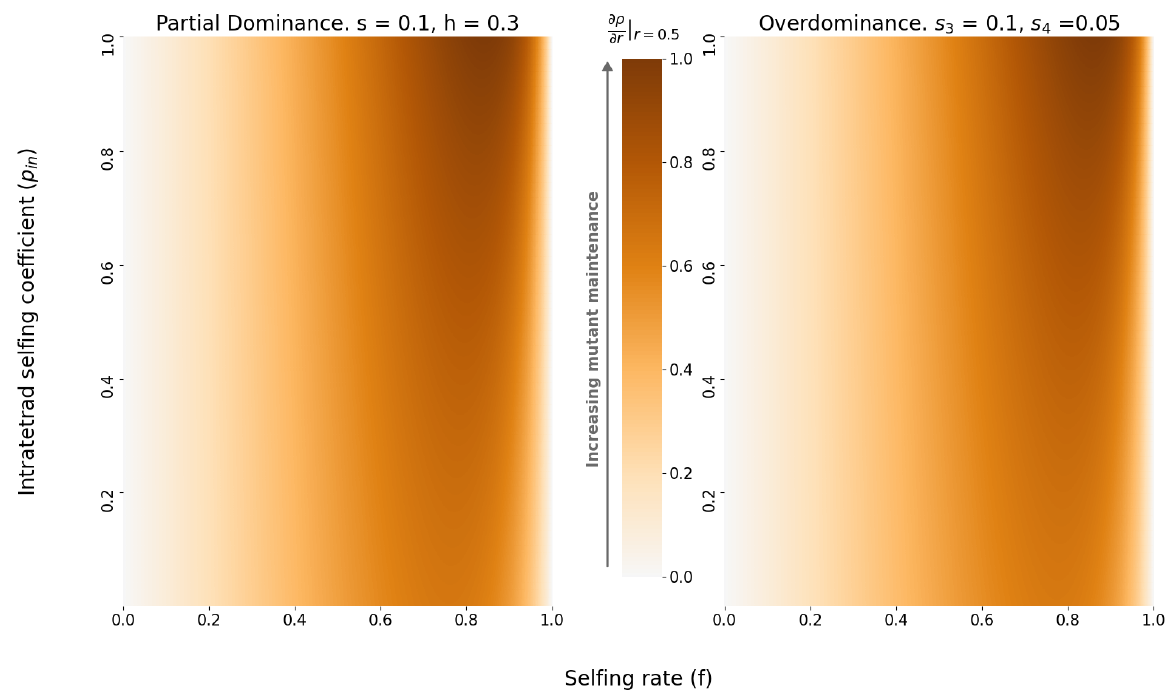
Figure 3 – Relative variation of the derivative of the dominant eigenvalue in the partial dominance case (left) and the overdominance case (right). For each panel, the values of ∂ρ ∂ r | r =0.5 range from a minimal value, which is negative, to zero. We divided each value of the derivative by this minimum in order to plot values between 0 and 1 for every panel. This enables us to compare the effect of the presence of a mating-type locus on the same scale for both selection scenarii. x-axis: selfing rate f . y-axis: intratetrad selfing rate p in . The darker the color, the more the mating-type locus shelters the mutation, thus promoting its